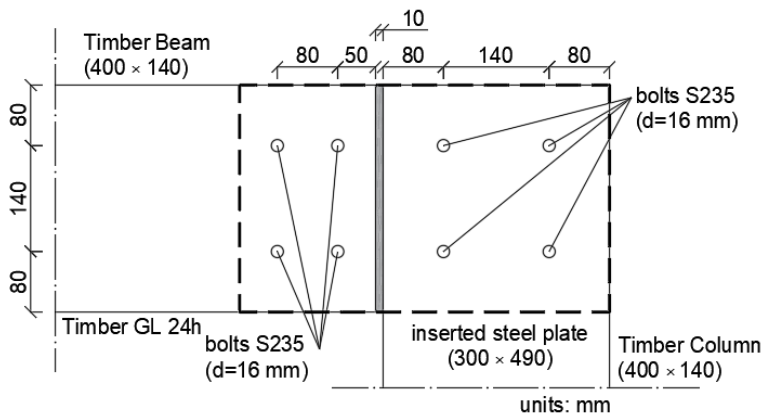
Figure 9. Steel–timber joint layout (adapted from Ref. [32]).